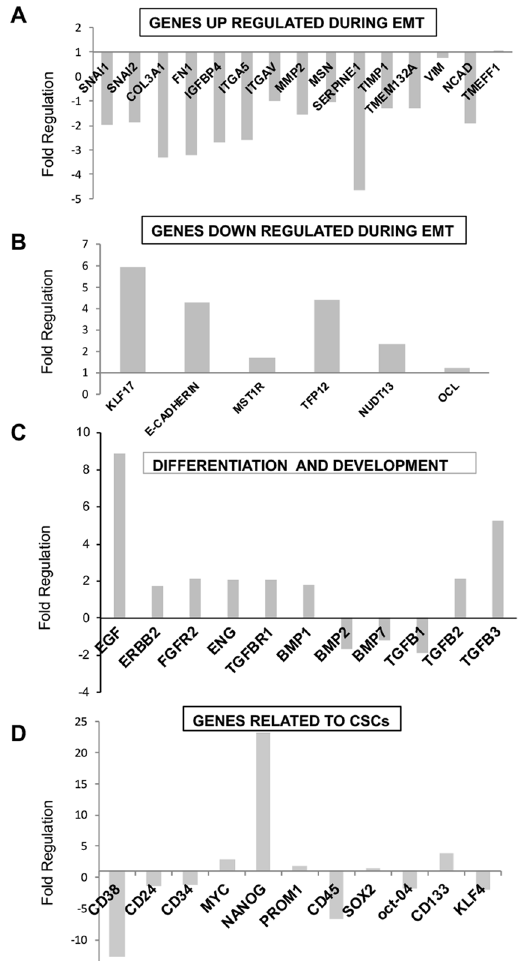
Figure 2. Gene expression profiling of BxPC3 CSCs treated with PRP using RNA Human EMT and CSCs RT2 Profiler PCR Array. BxPC3 CSCs were treated with PRP on day 2 and on day 4. On day 5, total RNA from treated and non-treated CSCs was extracted. A pool of three total RNAs extracted from three independent experiments was used for first strand cDNA synthesis. Gene expression was determined using RT 2 Profiler PCR Array of EMT and CSCs. ( A ) Expression of genes up regulated during EMT. ( B ) Expression of genes down regulated during EMT. ( C ) Expression of genes related to differentiation and development. ( D ) Expression of genes related to CSCs. All gene expressions were normalised to the untreated